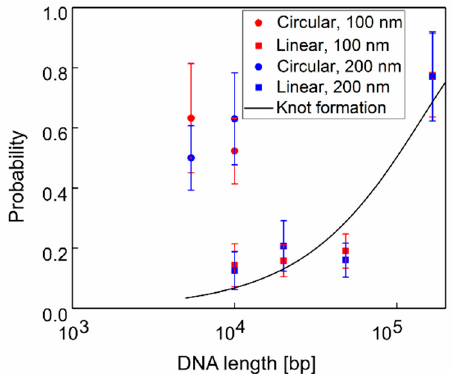
Figure 1. Clog probability vs. DNA length and its shape-linear (squares) or circular (circles) for pore diameters of 100 nm (red) and 200 nm (blue). Error bars represent the standard deviation of each data point. The solid line is the analytical prediction of knot formation, 1 − exp( − N/N 0 ), where N 0 = 143 ± 5 kbp by Plesa et al. [27].